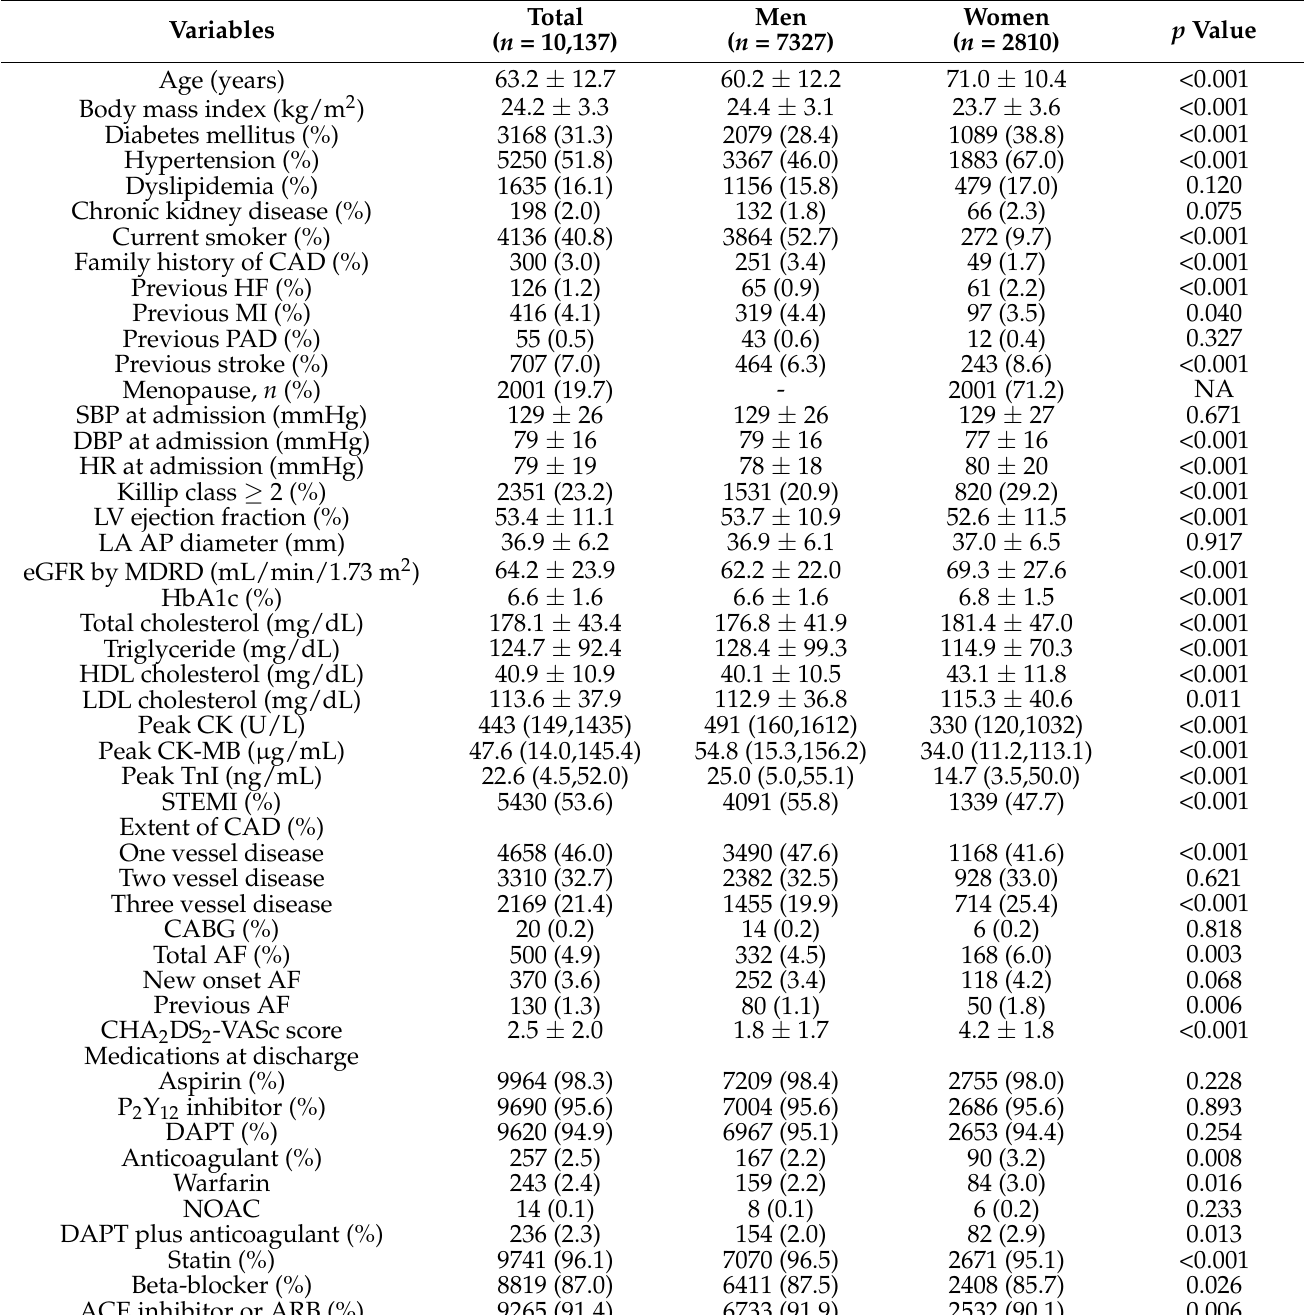
Table 1. Baseline